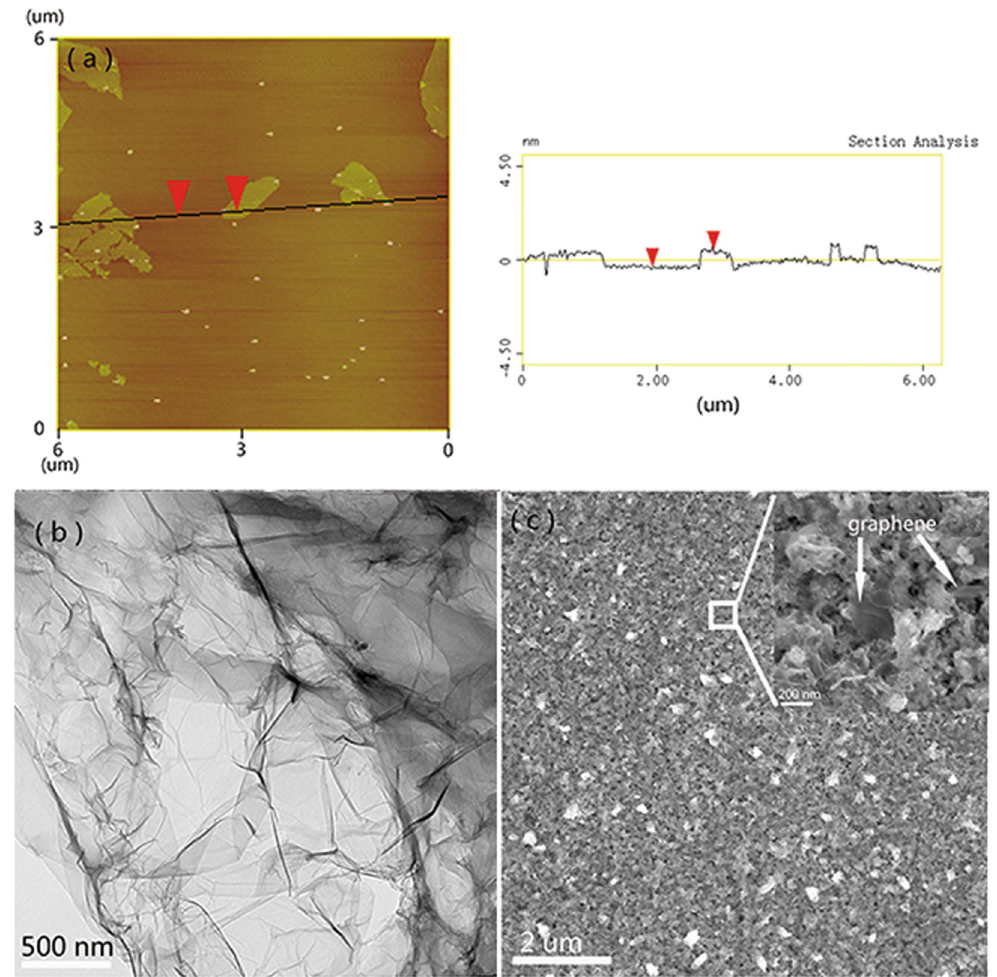
Figure 2. ( a ) AFM image of as-prepared GO sheets deposited onto a mica substrate. The height profile along the black line indicated a sheet thickness of GO was about 0.82 nm. ( b ) TEM image of single layer GO, showing the wrinkled nature of the GO. ( c ) SEM image of RGO/Cu composites after etch at nitric acid solution for 30 seconds. The inset revealed graphene uniformly embedded in the copper matrix (graphene was marked by